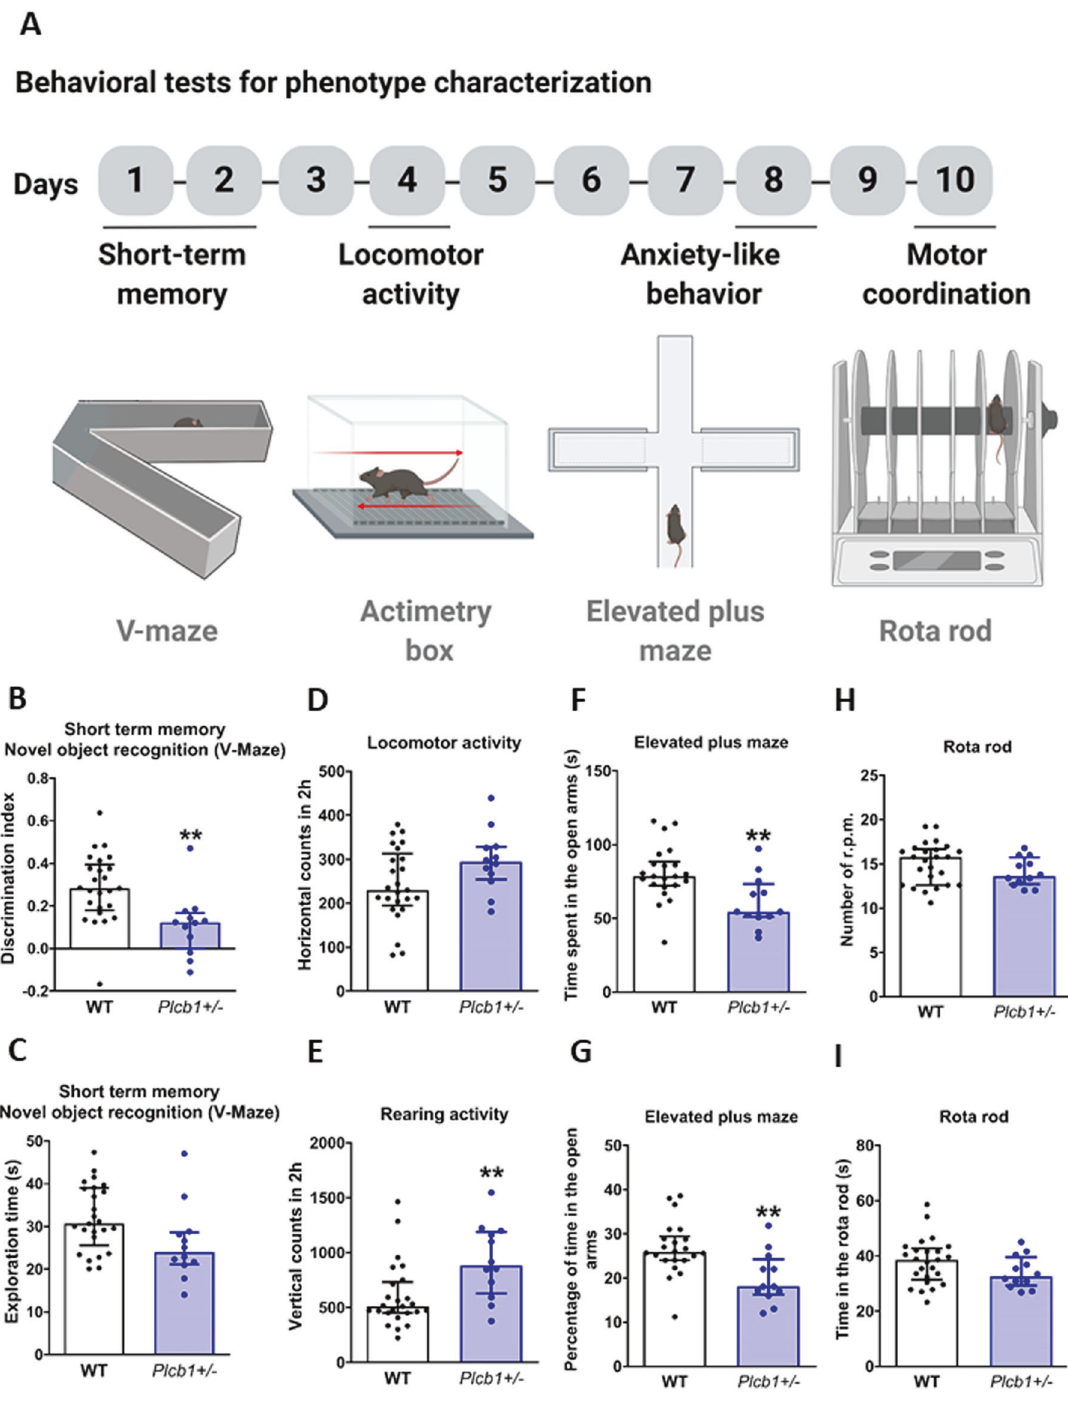
Fig. 1 Behavioral tests for phenotype characterization. A Timeline of the experimental sequence. B , C Short-term memory measured in the V-maze for novel object recognition task, ( B ) discrimination index ( t -test, ** P < 0.01 vs WT) and ( C ) exploration. D Locomotor and ( E ) rearing activity measured in actimetry boxes ( U -Mann – Whitney, ** P < 0.01 vs WT). F Anxiety-like behavior measured by the time spent in the open arms ( t -test, ** P < 0.01 vs WT) and ( G ) the percentage of